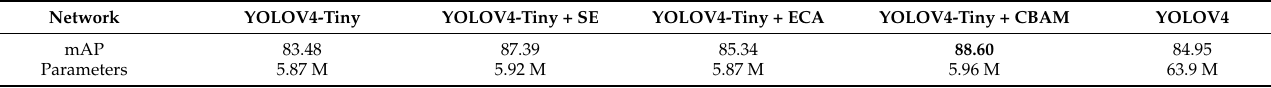
Table 1. Accuracy comparison of the incorporation of different attention